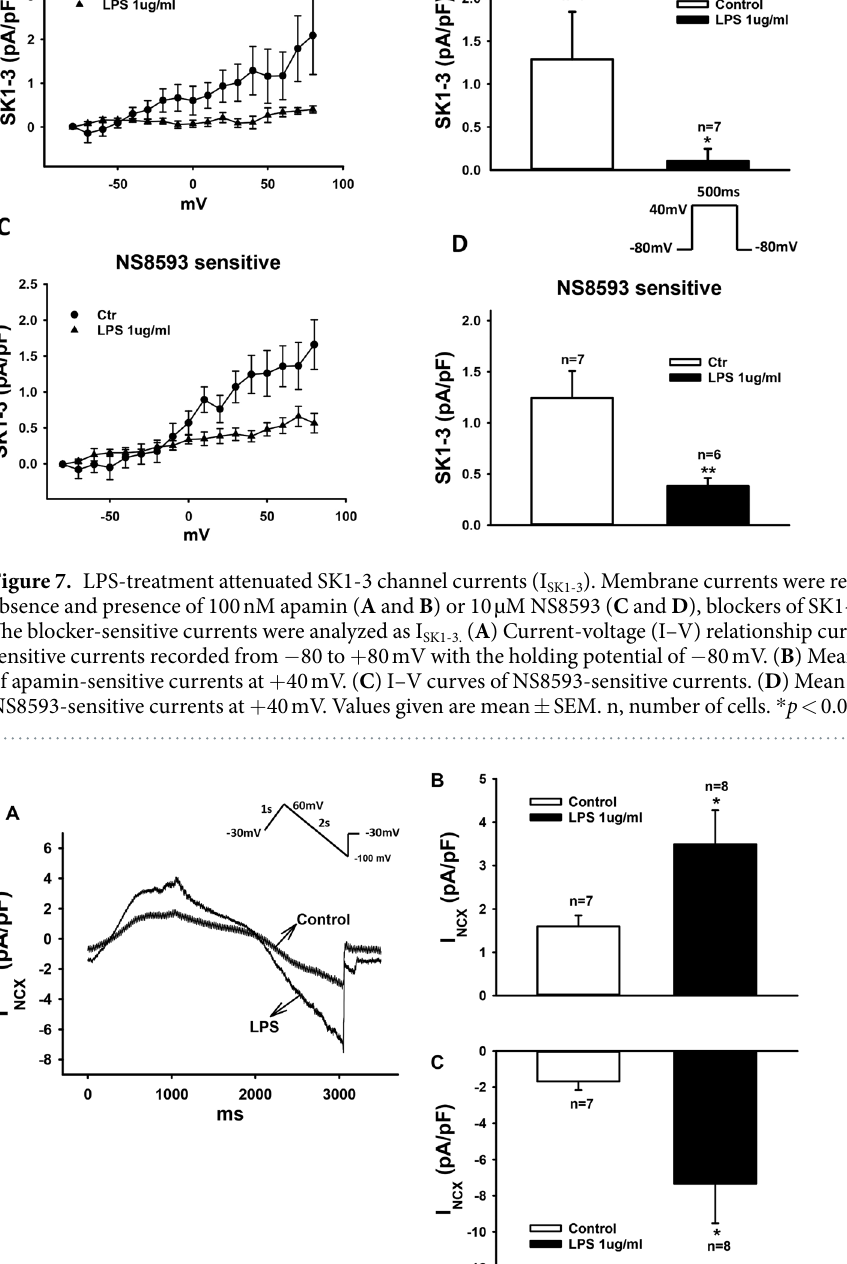
or when stimulated. They possess most ion channels reported to exist in human cardiomyocytes and dis- played electrophysiological properties similar to that of native cardiomyocytes. Therefore we tried to establish a hiPSC-CM-model mimicking LPS-induced inflammation in cardiac myocytes, which is still lacking.